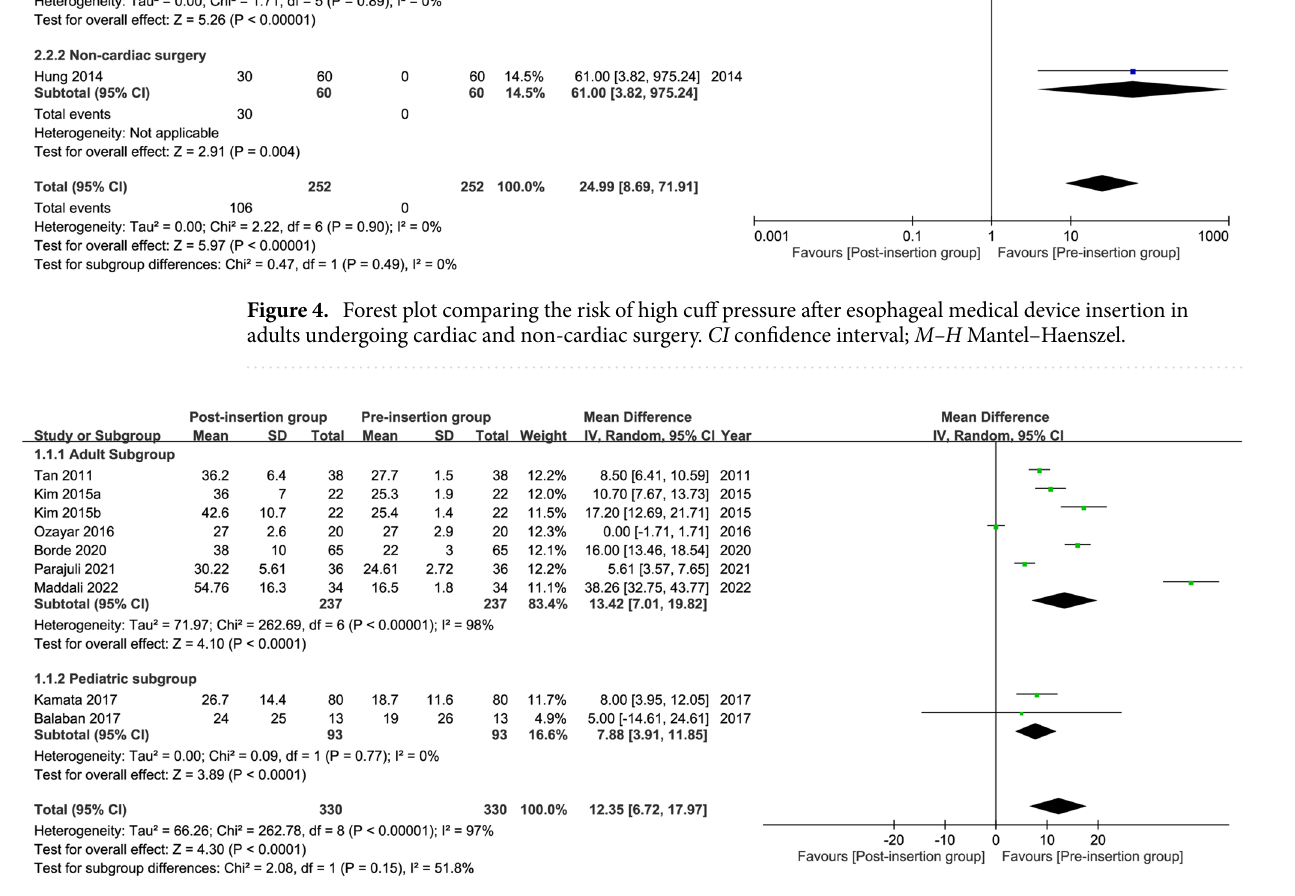
Figure 5. Forest plot for the comparison of changes in cuff pressure during esophageal medical device insertion. CI confidence interval; IV inverse